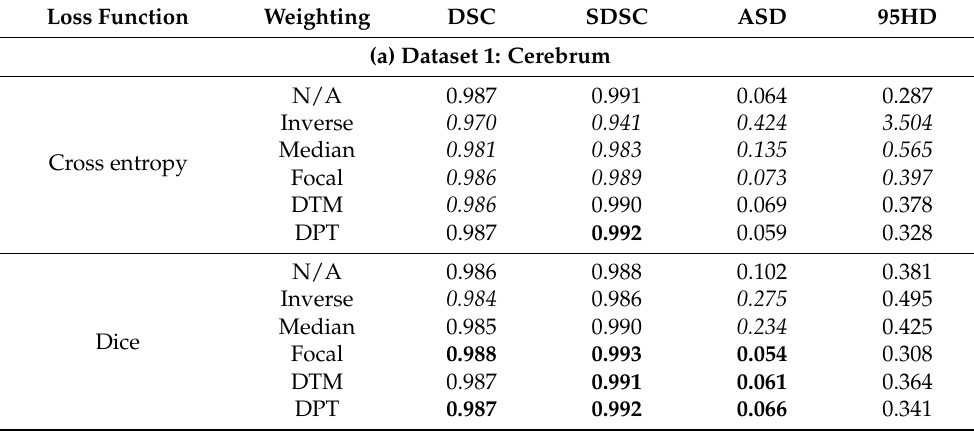
Table 4. Segmentation results of no weighting (N/A), inverse frequency weighting (Inverse), inverse median frequency weighting (Median), focal weighting (Focal), distance transform map-based weight- ing (DTM), and distance penalty term-based weighting (DPT) in binary-class segmentation tasks: Dice similarity coefficient (DSC), surface DSC (SDSC), average symmetric surface distance (ASD) (mm), and 95th-percentile Hausdorff distance (95HD) (mm). (a) Dataset 1: cerebrum, (b) Dataset 2: cerebellum, (c) Dataset 3: brainstem, and (d) Dataset 4: blood vessels. The results of background class are excluded in this table. Compared with the results of N/A, the significantly better and worse results are shown in bold and italic, respectively (Wilcoxon signed-rank test, p < 0.05, not adjusted for